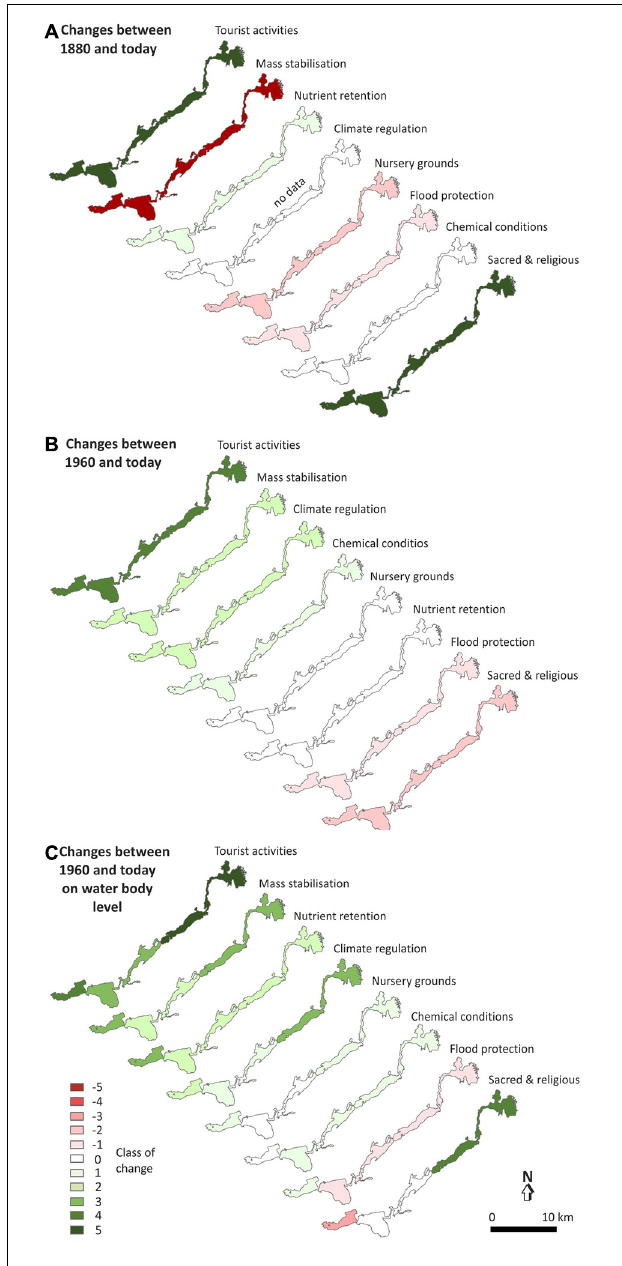
FIGURE 5 | Selected comparative ecosystem service assessments in the Schlei Estuary: (A) changes between 1880 (high ecological status of the WFD) and today, averaged over the estuary, (B) averaged changes between 1960 and today, averaged over the estuary, and (C) changes between 1960 and today on water body